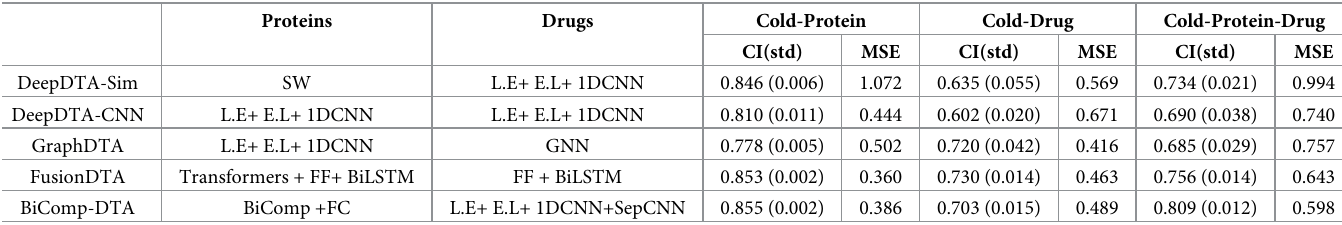
Table 6. The CI and MSE values for the BiComp-DTA compared to the alternative methods considering cold-start settings- Davis dataset.